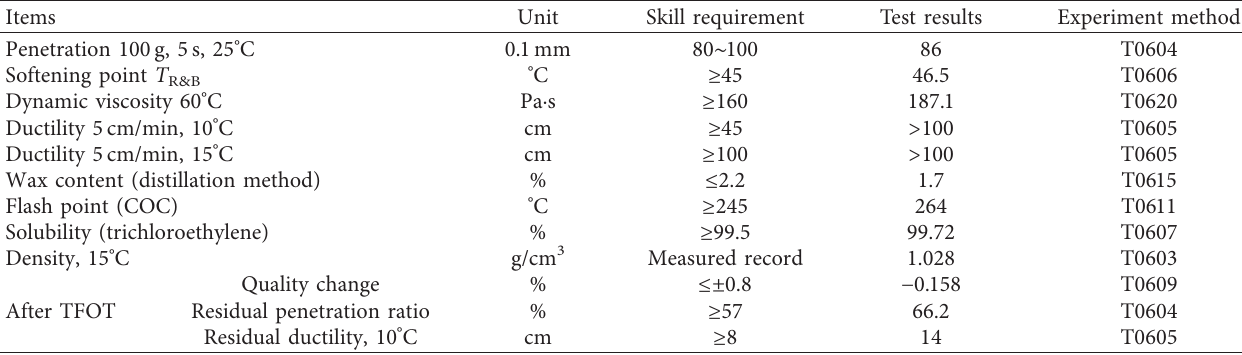
Table 1: Properties of no. 90 A asphalt.